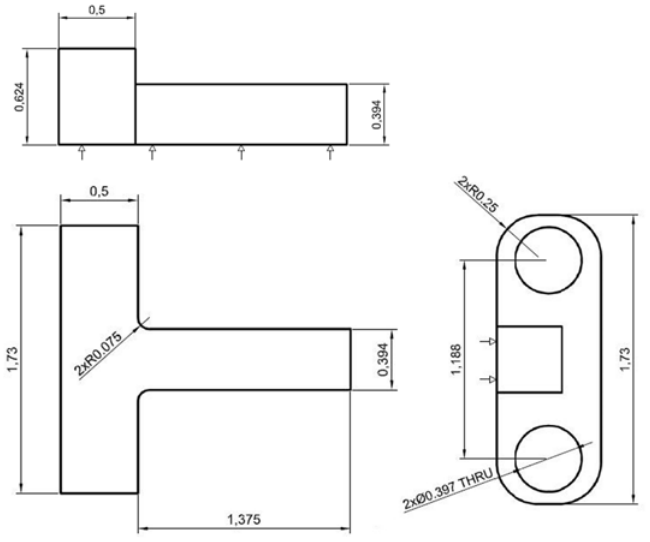
Figure 2. T-shape coupon used for LIE test. Dimensions are in inches. The arrows indicate the burnished surface.